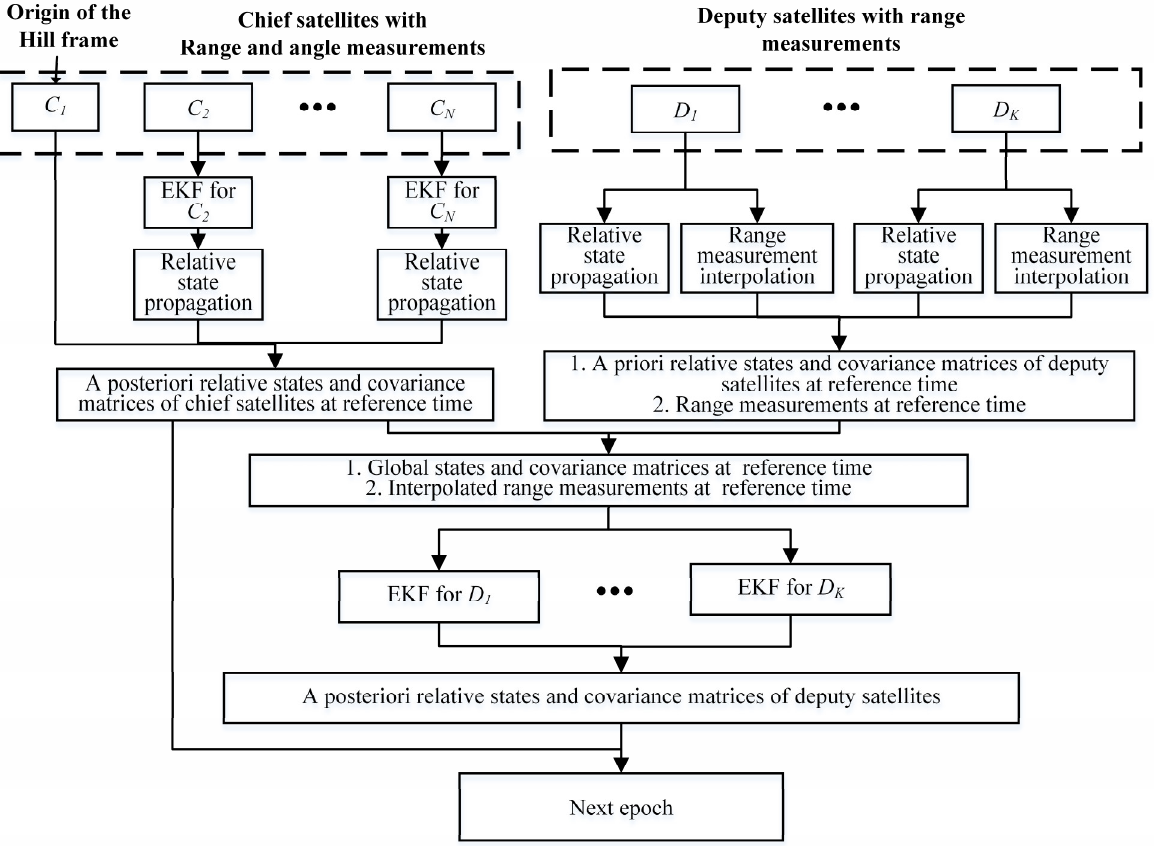
Figure 6. Flowchart of the multi-satellite relative navigation algorithm.